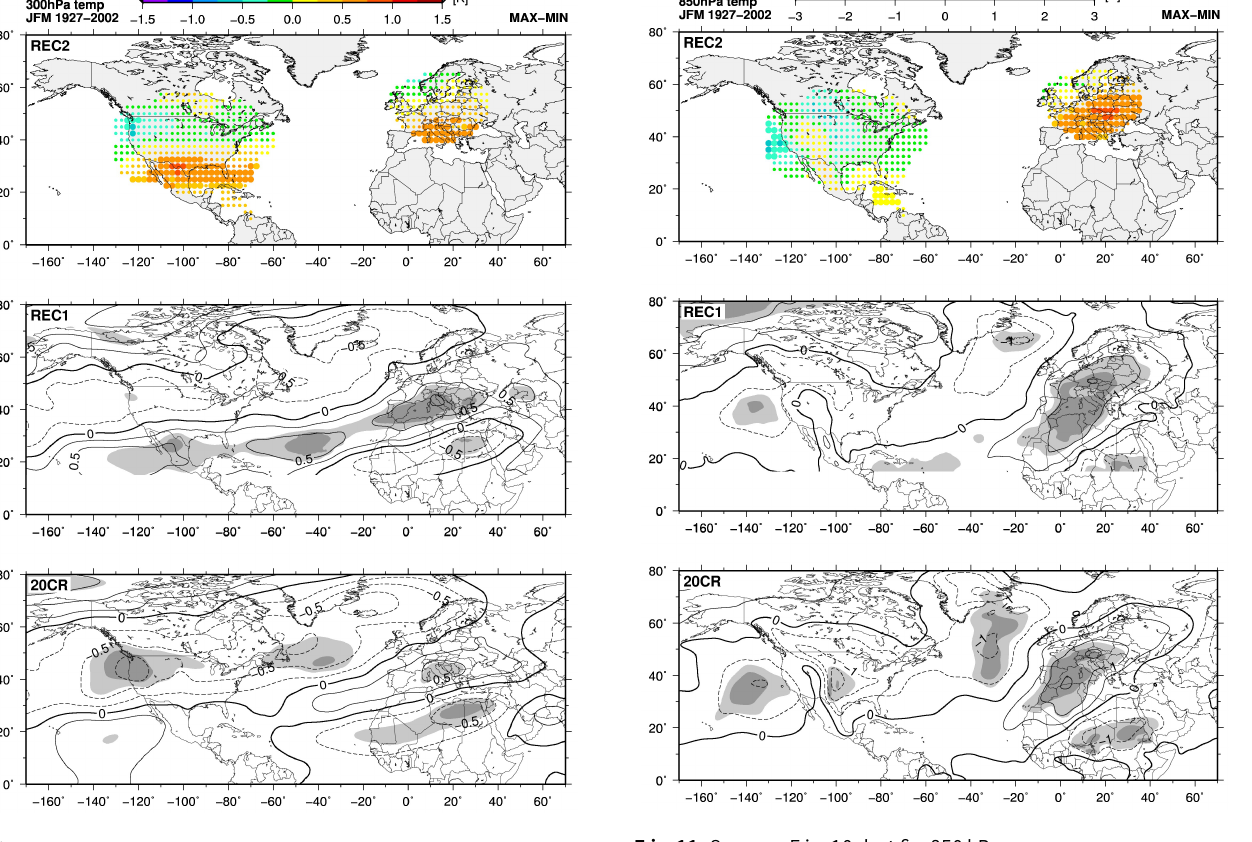
Fig. 10. Similar to Fig. 5, but showing temperature in K. Fig. 11. Same as Fig. 10, but for